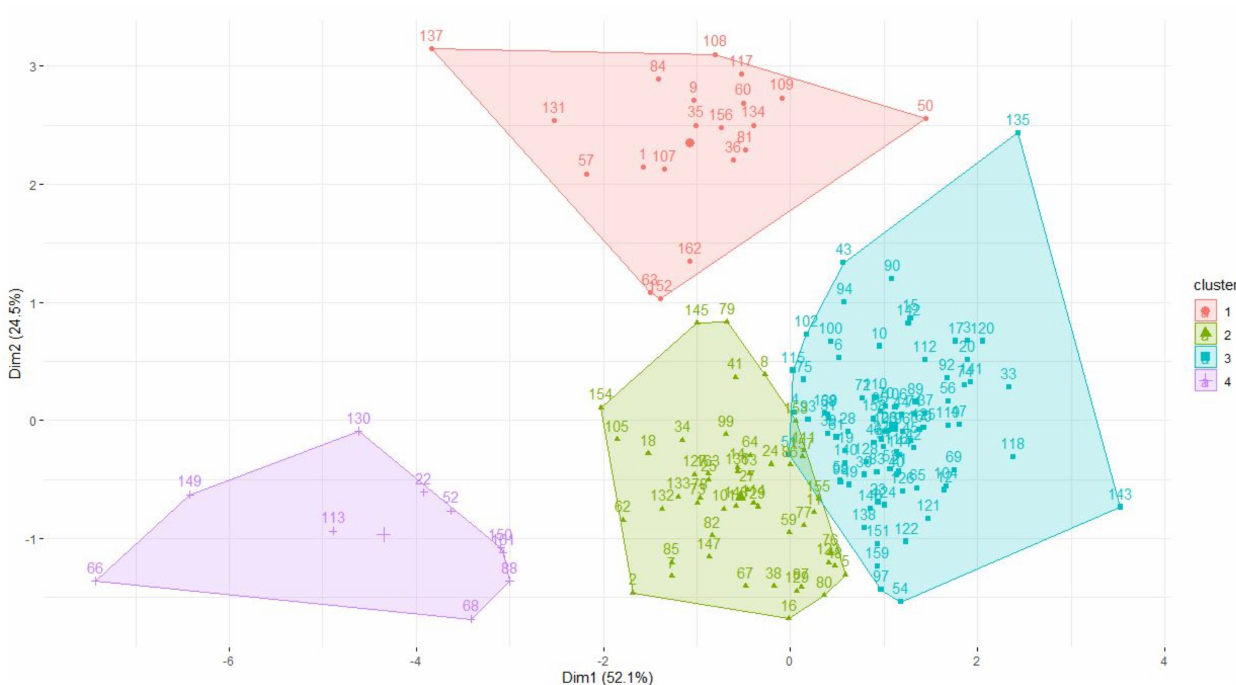
Figure 1. Clusters formed from analysing number of NTD, clutch size, incubation period, fledging time, body mass and generation length of waterbirds found in southern Africa. See Appendix A for the species represented by number